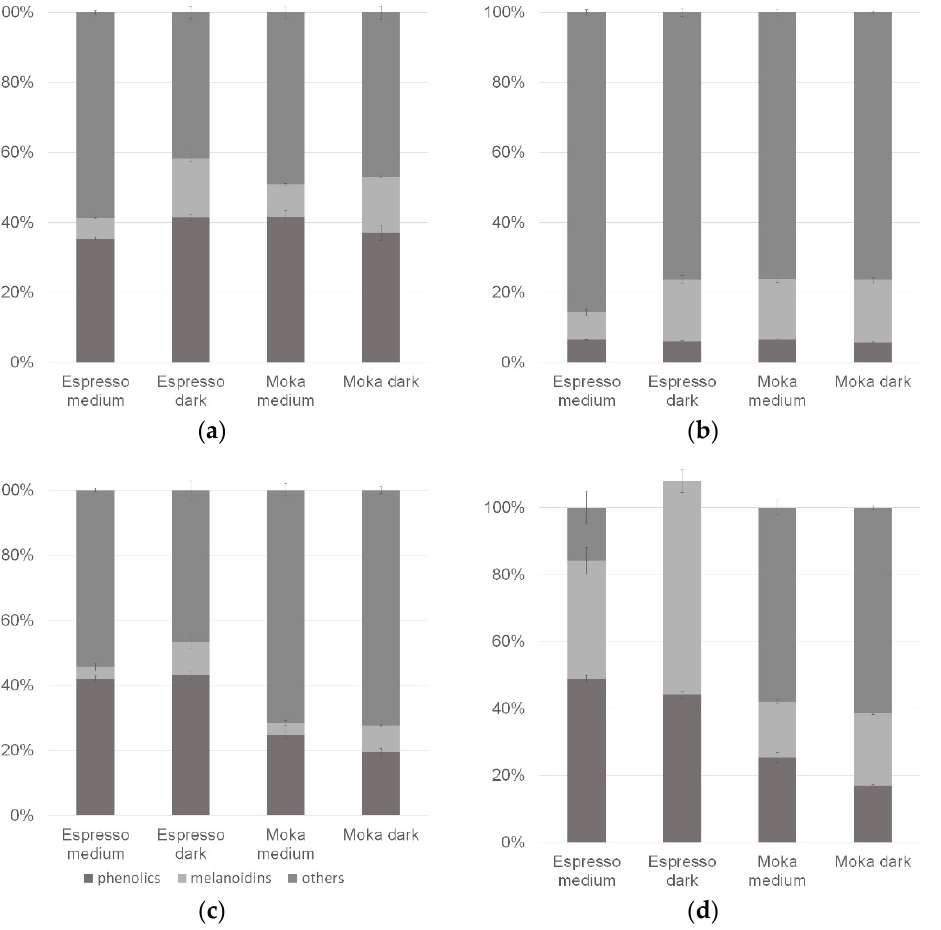
Figure 2. Activity of common classes of coffee compounds in the CUPRAC method ( a ), the ABTS method ( b ), the CBA method ( c ) and the method based on autoxidation of linoleic acid ( d ).